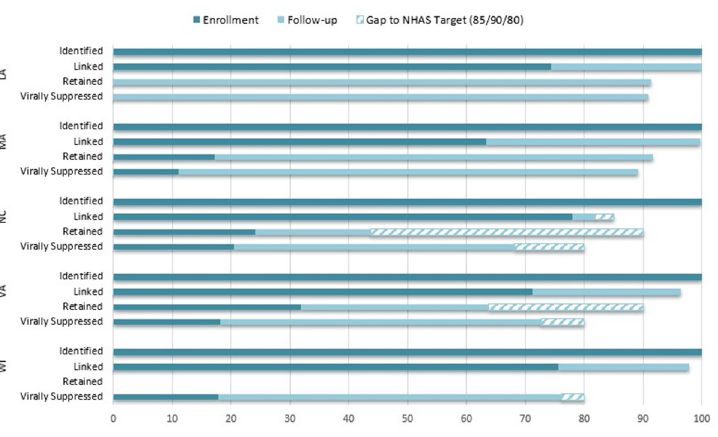
Fig 1. Patient navigation interventions: Estimated HIV care continuum outcomes at follow-up. LA, Louisiana; MA, Massachusetts; NC, North Carolina; NHAS, National HIV/AIDS Strategy; VA, Virginia; WI, Wisconsin.